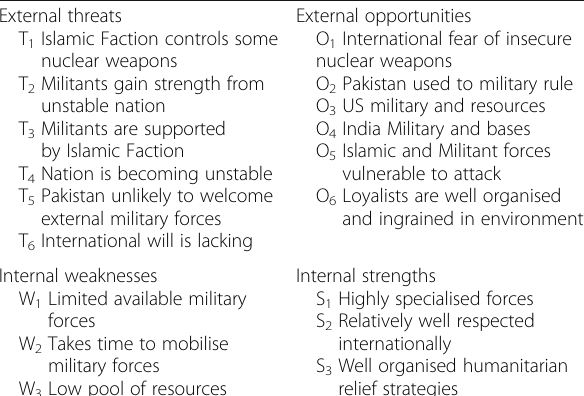
Table 3 TOWS part 1 — understanding the external threats